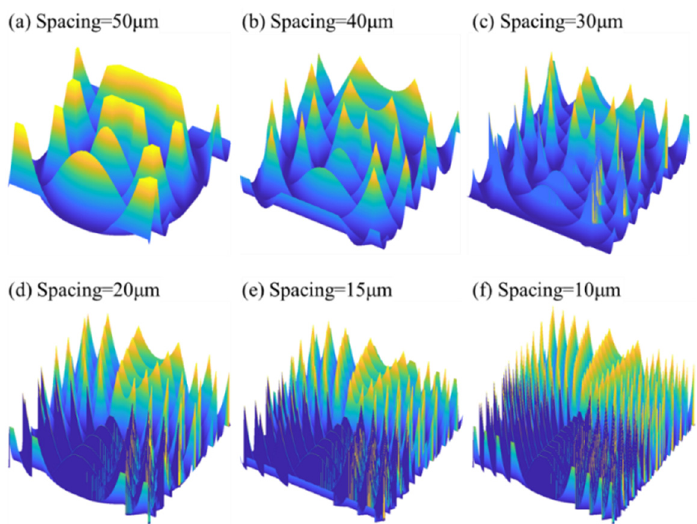
Figure 19. Comparison of simulated 3D surface topography of a polar microstructure with different groove spacing. Other important machining parameters: depth of cut: 5 μ m: tool nose radius: 43 μ m.